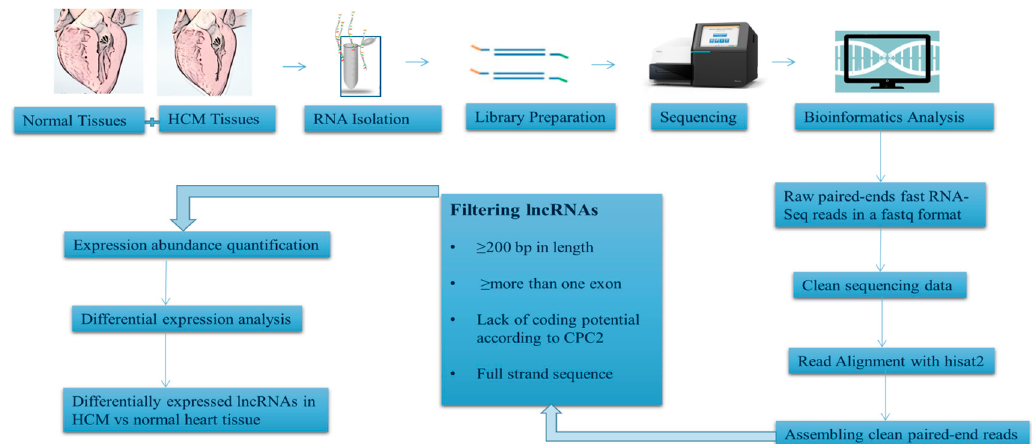
Figure 3. Schematic representation of experimental workflow involved in RNA-seq analysis of differentially expressed lncRNAs in normal and HCM patient’s sample.